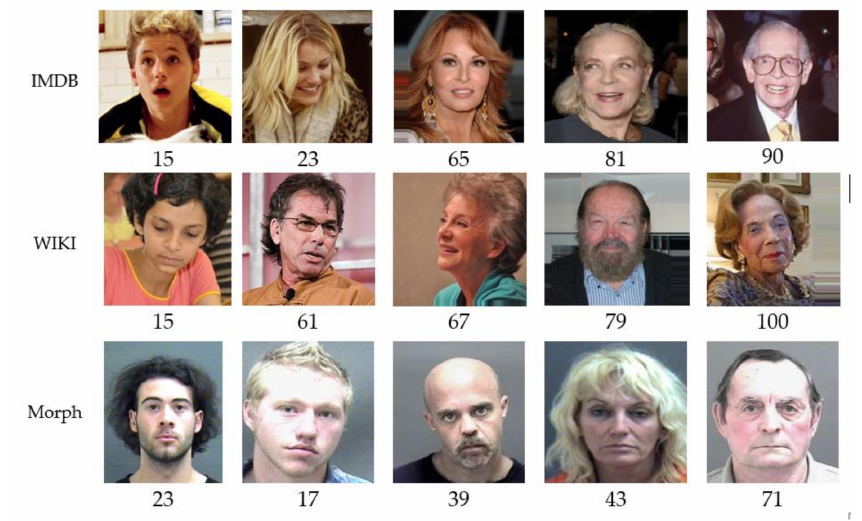
Figure 7. Exemplar images with real (biological) age from each dataset used in the age estimation experiment.